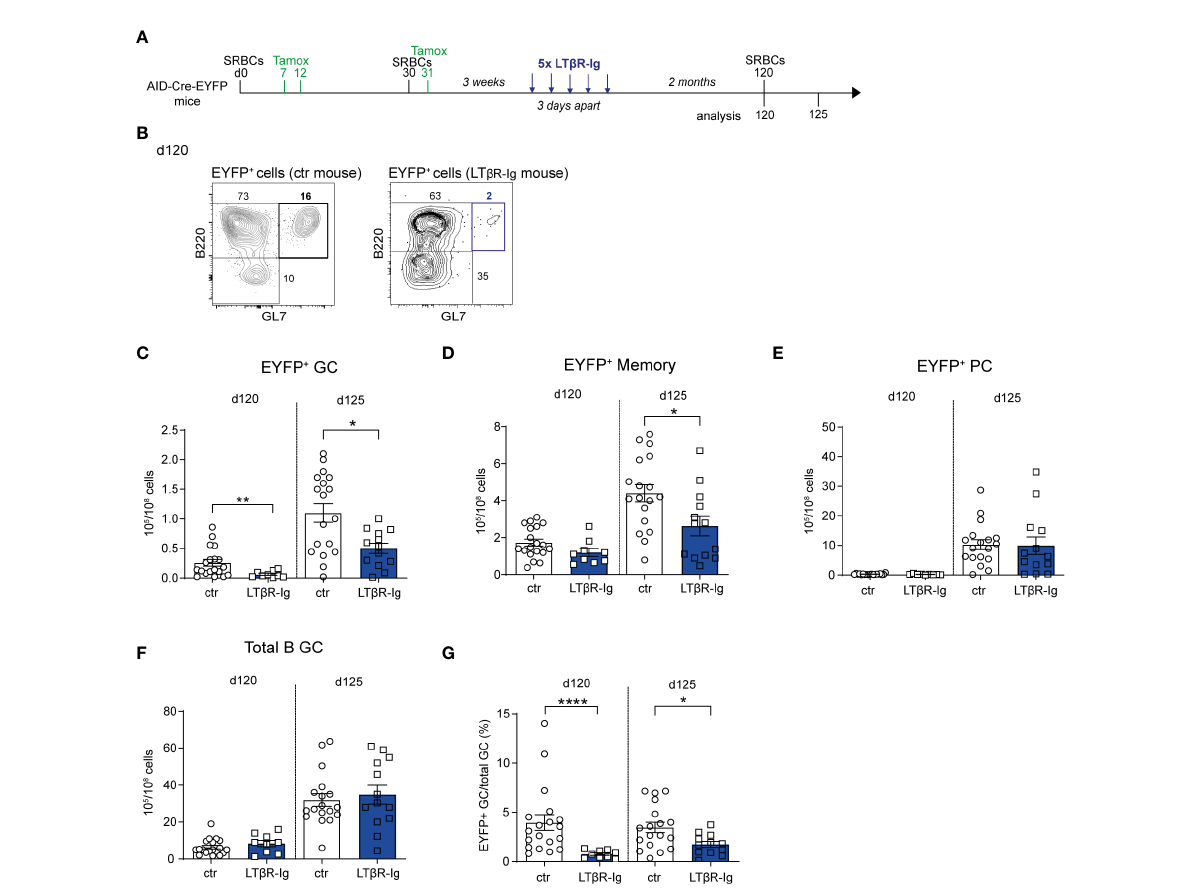
(Figure 5D). For the PC response, similar numbers of EYFP + PCs were observed in both boost timings (Figure 5E).